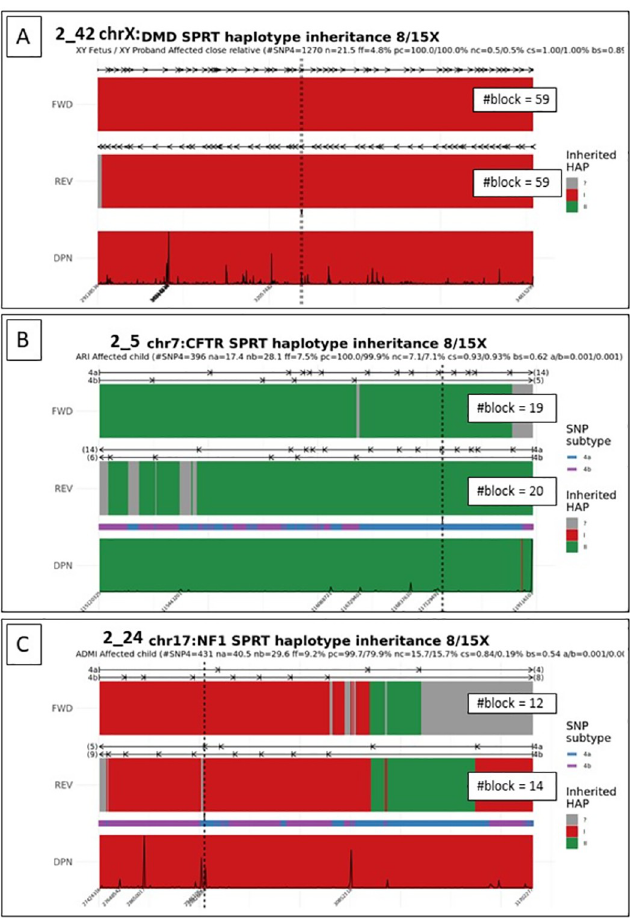
Fig 4. Examples of results with different quality scores. (A) Family 2_42 at risk of transmitting Duchenne/Becker muscular dystrophy. A high number of tested SNP4 (n = 1270) combined with a deep sequencing depth (mean = 211X) allowed the detection of a large number of blocks (59 haplotype blocks in forward direction and 59 haplotype blocks in reverse direction) with a high concordance in favor of the transmission of HapI (Sc = 1.00), despite a relatively low fetal fraction (f = 4.8%). Sb was estimated to be 0.89. (B) Family 2_5 at risk of transmitting cystic fibrosis. This family presented with a reasonable number of SNP4 (n = 396) and fetal fraction (f = 7.5%), but only a few haplotype blocks could be reconstructed (n = 39 blocks in forward + reverse directions) with a relatively high number of SNP4 per block (na = 17, nb = 28.1), resulting in a lower block score (Sb = 0.62). Note that the high concordance between forward and reverse analysis (Sc = 0.93), as well as the position of the maternal variant along the CFTR locus (black dashed line), still allow to conclude in favor or the transmission of HapII with high confidence. (C) Family 2_24 at risk for maternal transmission of neurofibromatosis type I. Only 26 haplotype blocks could be defined with a high mean number of SNPs per block (na = 40.5, nb = 29.6), resulting in longer blocks and therefore a lower block score (Sb = 0.54). Since 2/26 blocks were incorrectly classified as HapII instead of HapI, suggesting a SPRT error, the concordance score was estimated to be 0.84. Although the maternal variant is located in a concordant, HapI region, the small number of haplotype blocks, the haplotype change at the 3’ end of the locus, and the unclassified blocks at both ends prevent us from concluding on the fetal status for NF1. In a diagnostic setting, the analysis could be repeated on a subsequent sample. Sb: Bloc Score; Sc: Concordance score; na: mean number of SNP4a per haplotype bloc; nb: mean number of SNP4b per haplotype bloc; f: fetal